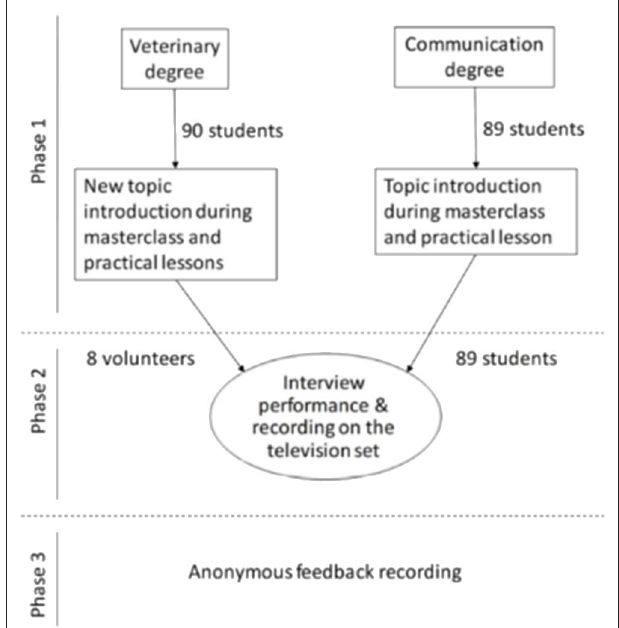
FIGURE 1 | Schematic presentation of the